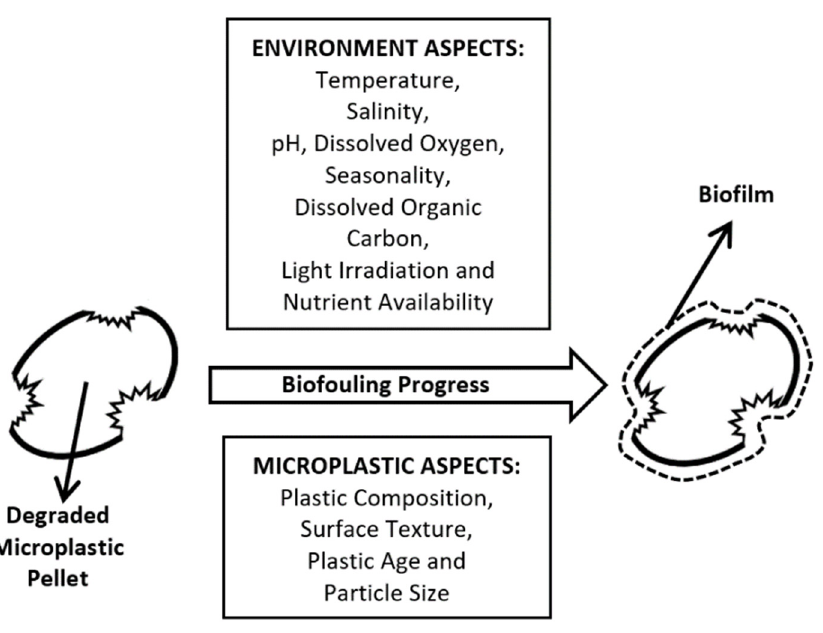
Figure 2. Site and microplastic influential aspects of biofilm formation.